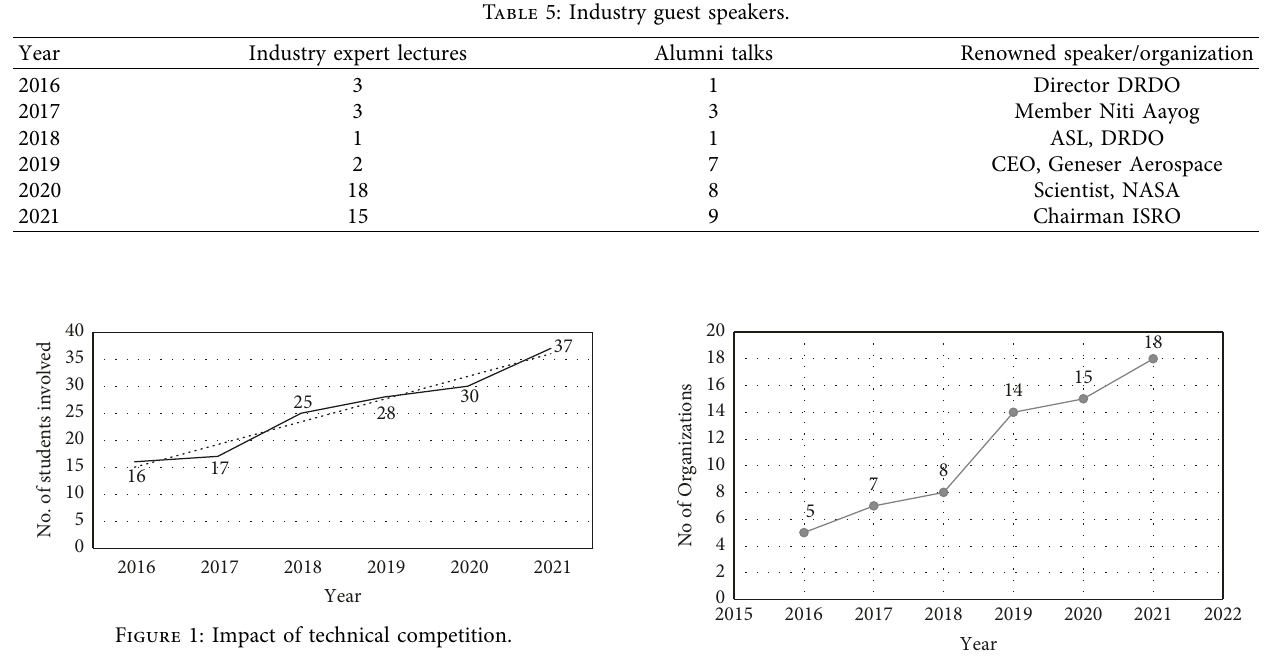
Figure 2: Analysis of industrial